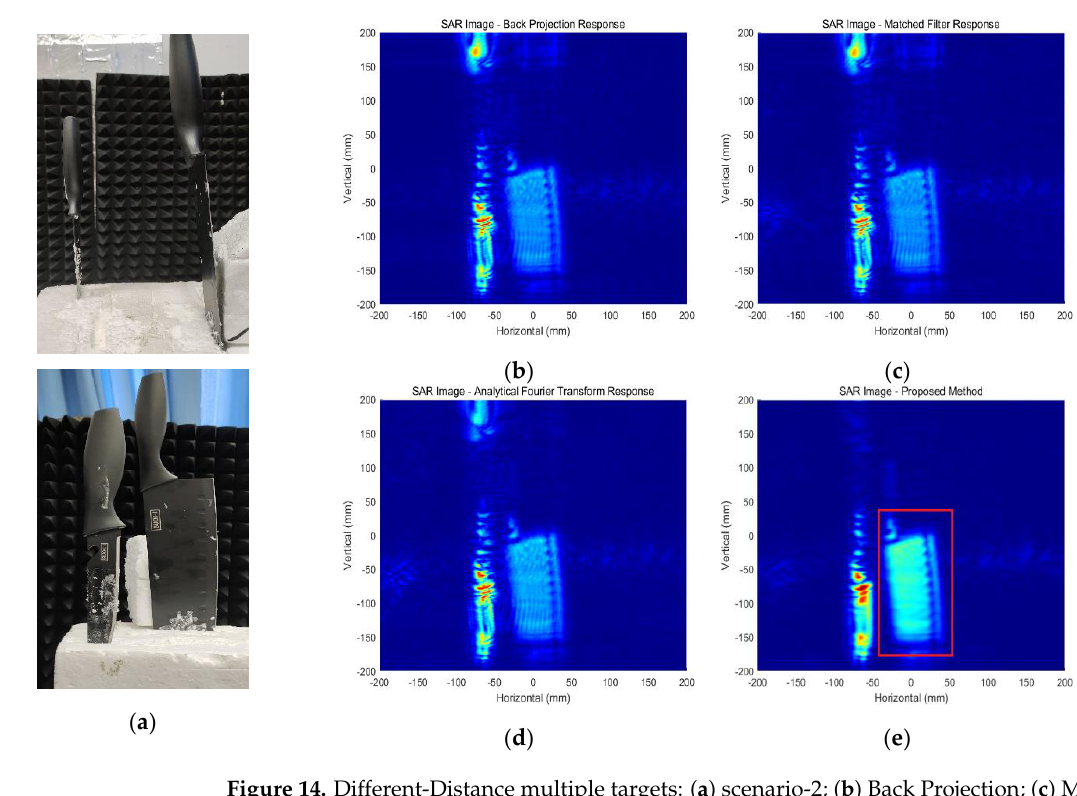
Figure 14. Different-Distance multiple targets: ( a ) scenario-2; ( b ) Back Projection; ( c ) Matched Filter; ( d ) Analytic Fourier Transform; ( e ) mmSight (red frame: projection of other target).